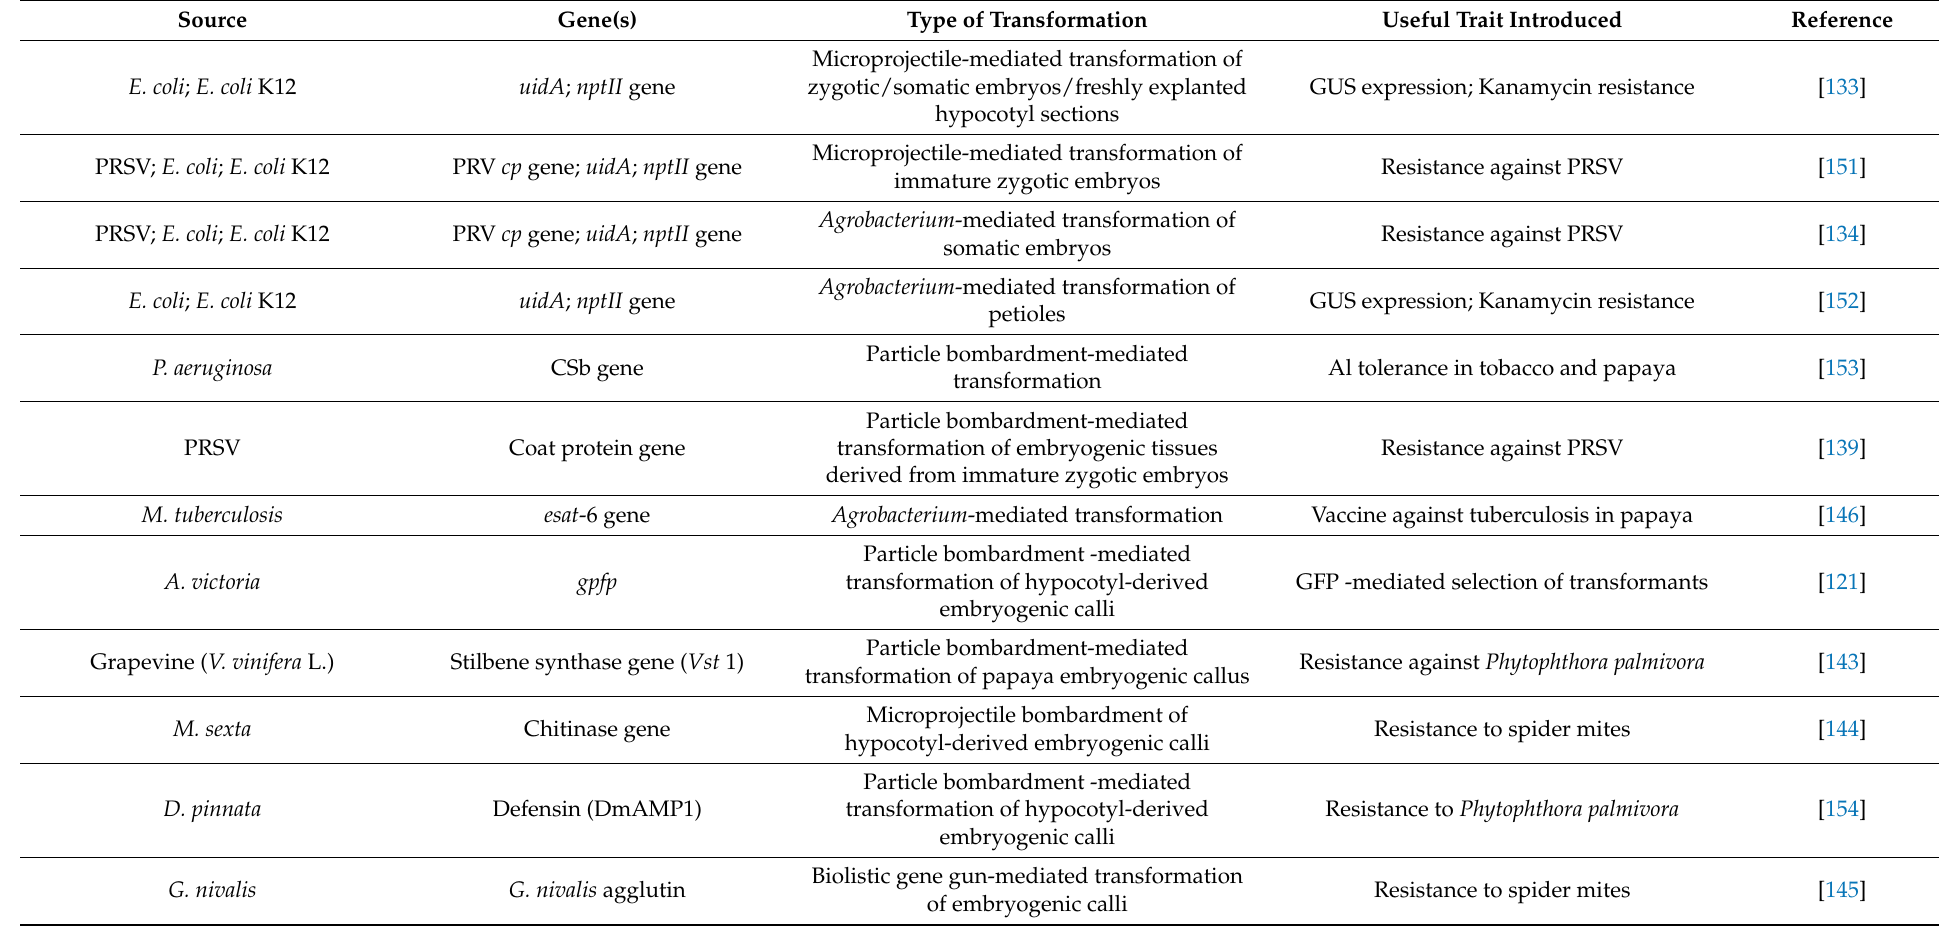
Table 3. Reports on the development of transgenic